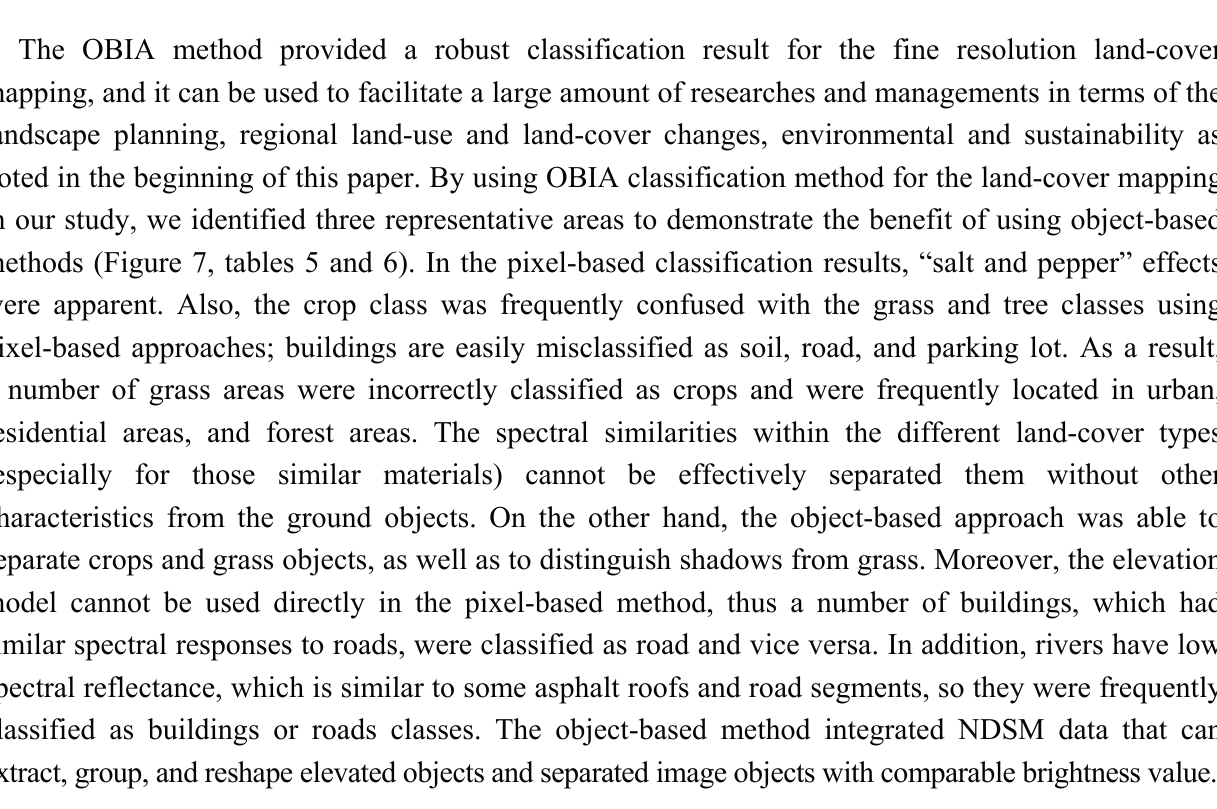
Figure 7. A comparison between pixel-based and object-based classification